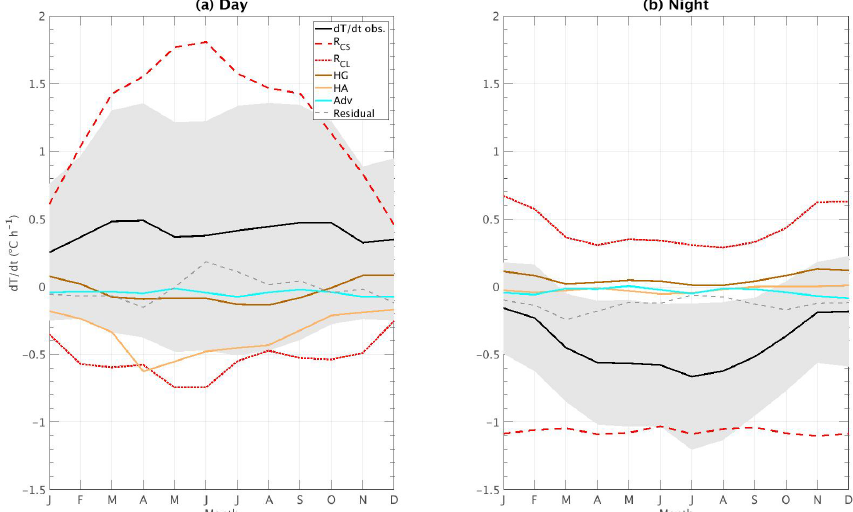
Figure 3. Mean annual cycle averaged monthly from 2009 to 2014 of the five terms of the model, the observations, and the residual (dashed gray lines) for (a) day and (b) night. Same colors as in Fig. 2a and b. The shaded gray area in each of the panels represents the standard deviation of ∂T 2m . ∂t obs